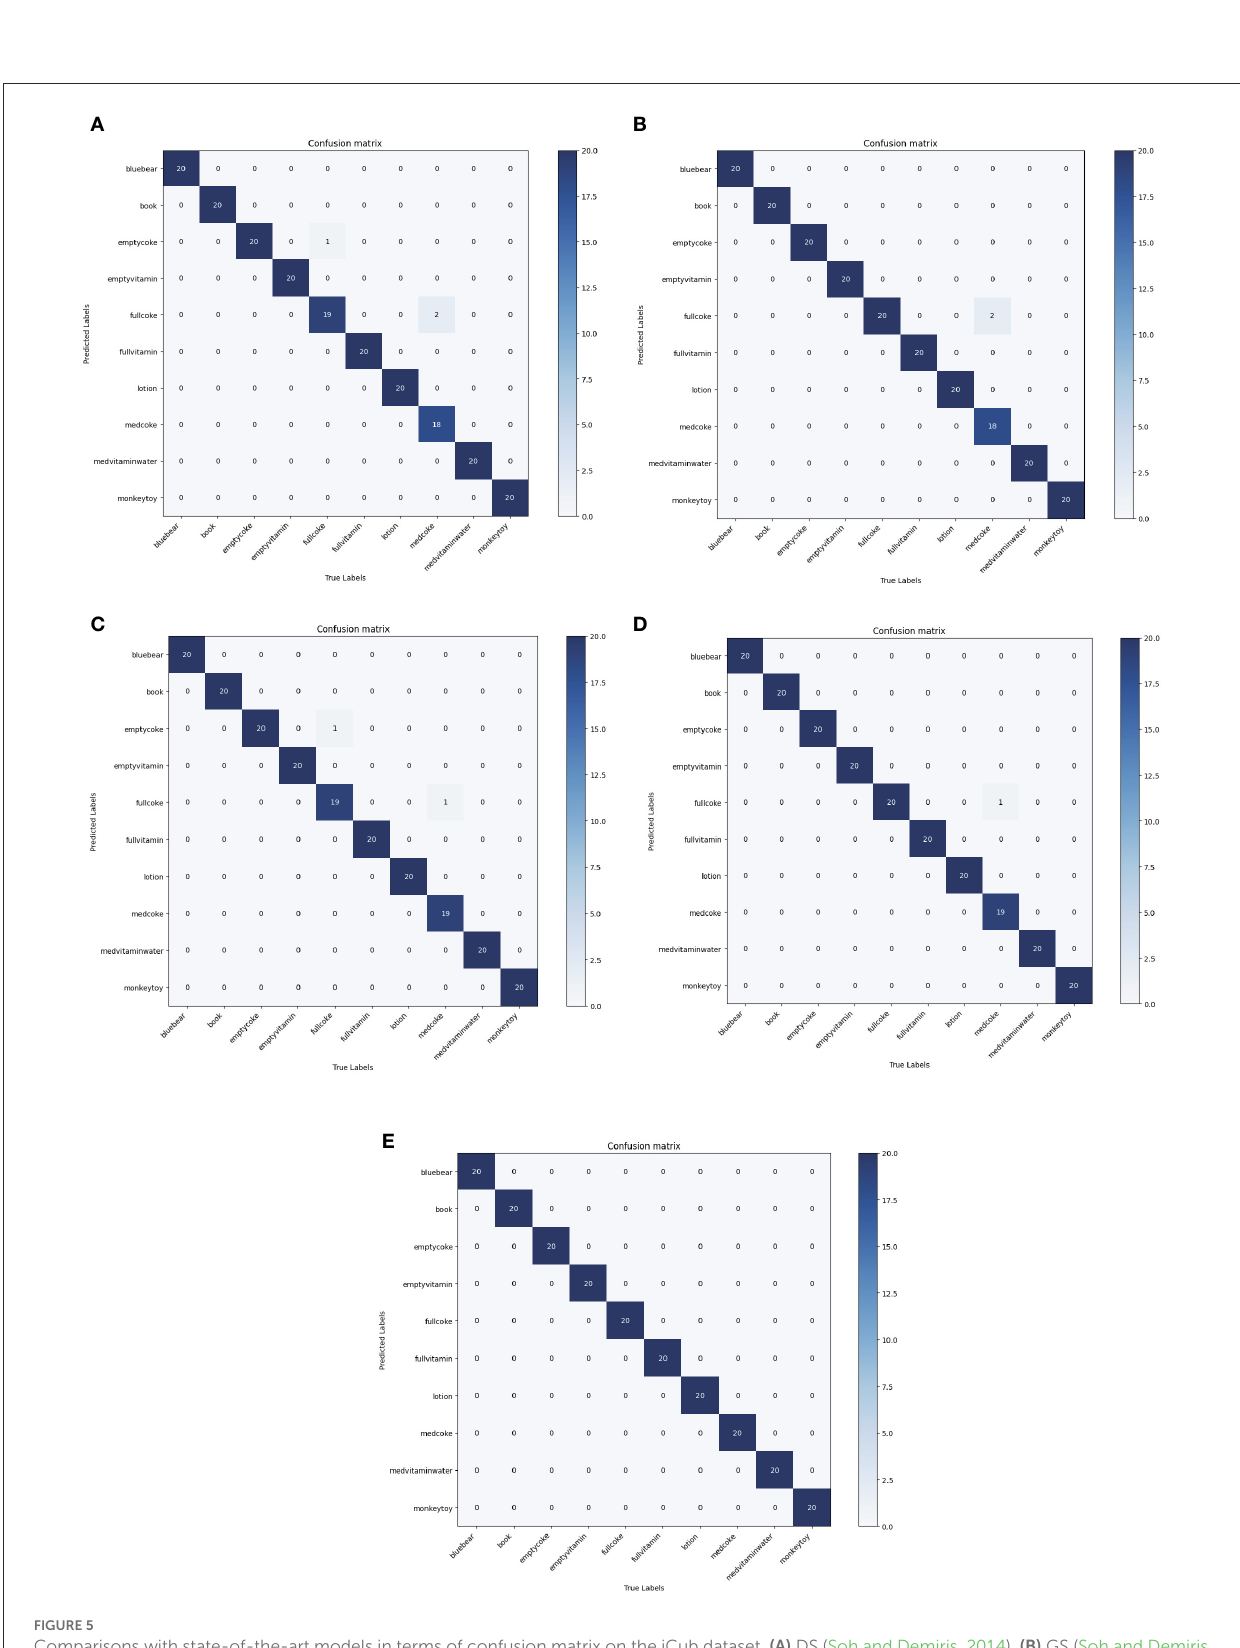
FIGURE5 Comparisons with state-of-the-art models in terms of confusion matrix on the iCub dataset. (A) DS (Soh and Demiris, 2014), (B) GS (Soh and Demiris, 2014), (C) Soh et al., 2012, (D) Sundaram et al., 2019, (E)